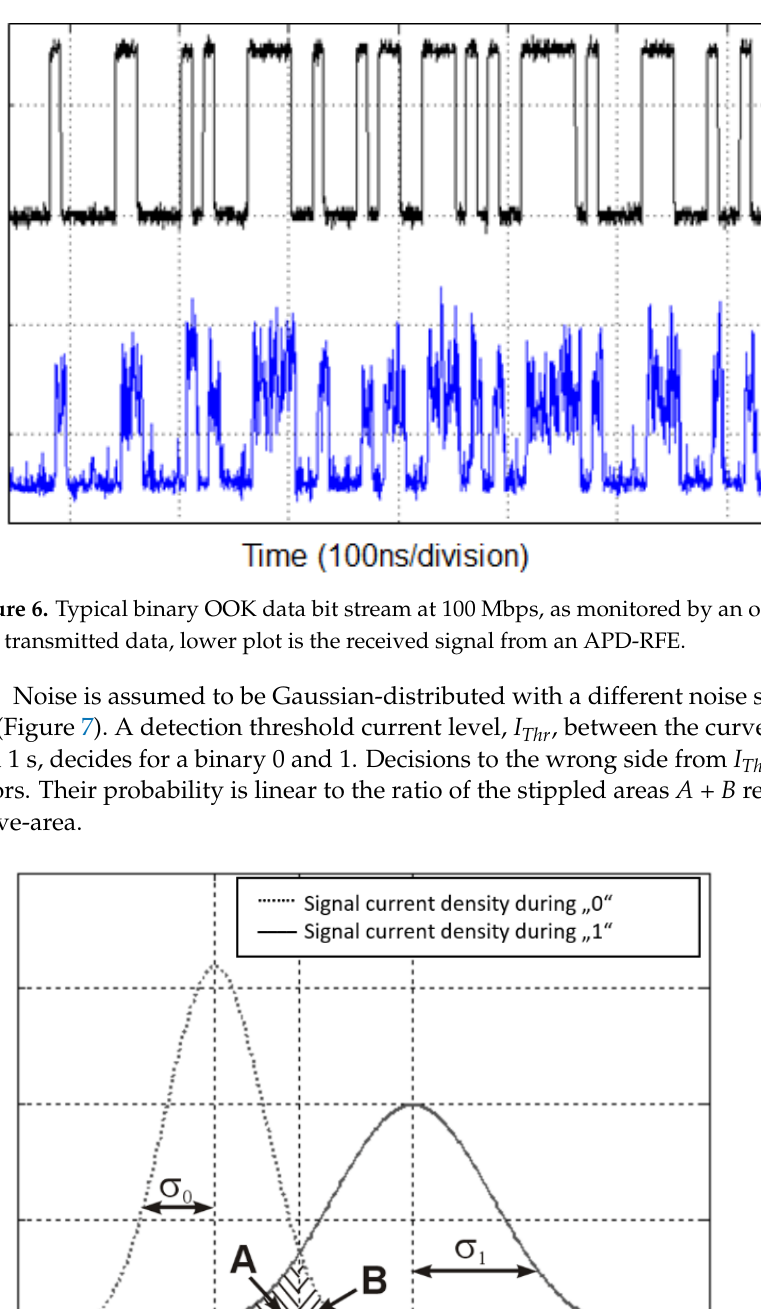
(12) Assuming <s 0 > = 0 (no offset), by integrating over the tails of the two Gaussian dis- tributions, we get the bit error probability, p BE .